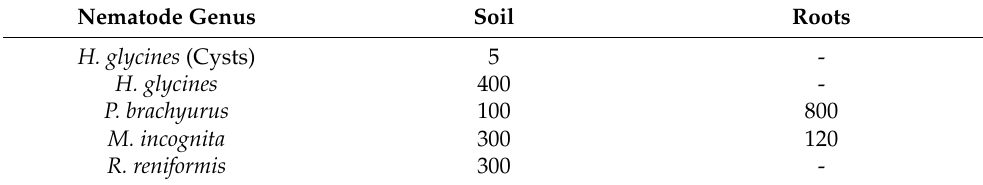
Table 3. Thresholds to classify asymptomatic and symptomatic plants for the training model. Nematode Genus Soil Roots H. glycines (Cysts) 5 - H. glycines 400 -